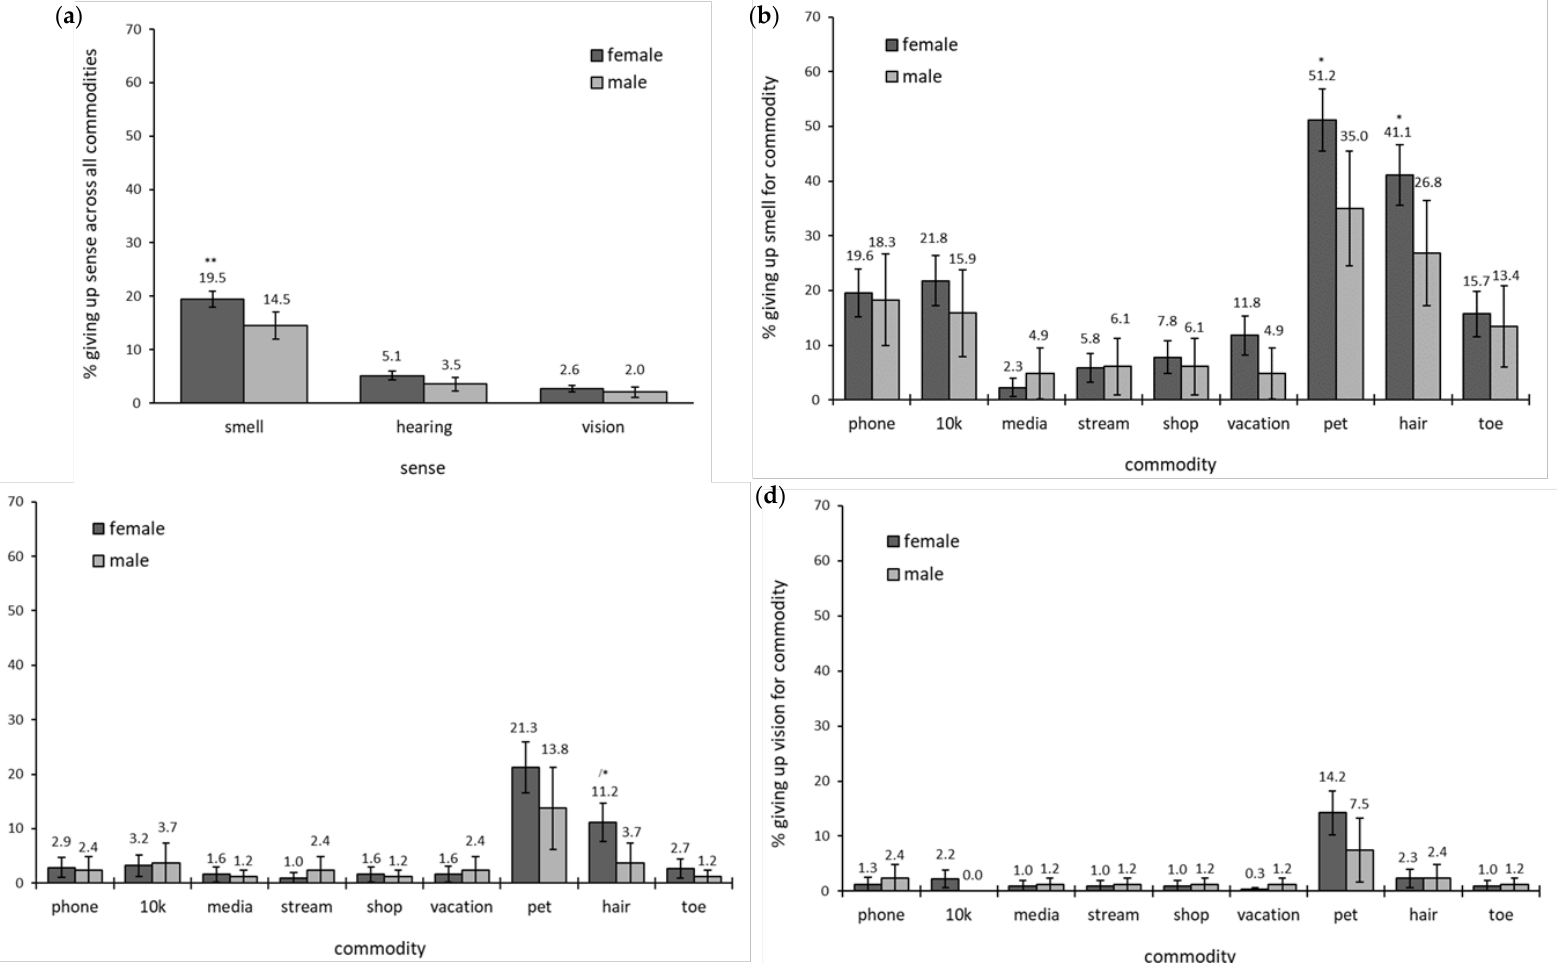
Figure 3. Willingness to give up each sense between Female and Male gender groups ( a ) by responses collapsed over all commodities for each sense, ( b ) by responses to each commodity compared to smell, ( c ) by responses to each commodity compared to hearing, ( d ) by responses to each commodity compared to vision. Note: significance indicated by * p < 0.05, ** p < 0.01; / indicates caution on interpretation due to low number of responses of one of the comparators (for details see Methods